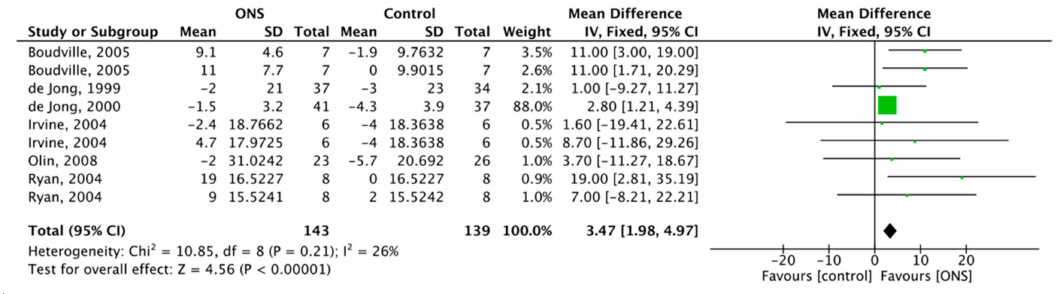
Figure 8. Forest plot comparing the effect of ONS on fat intake.